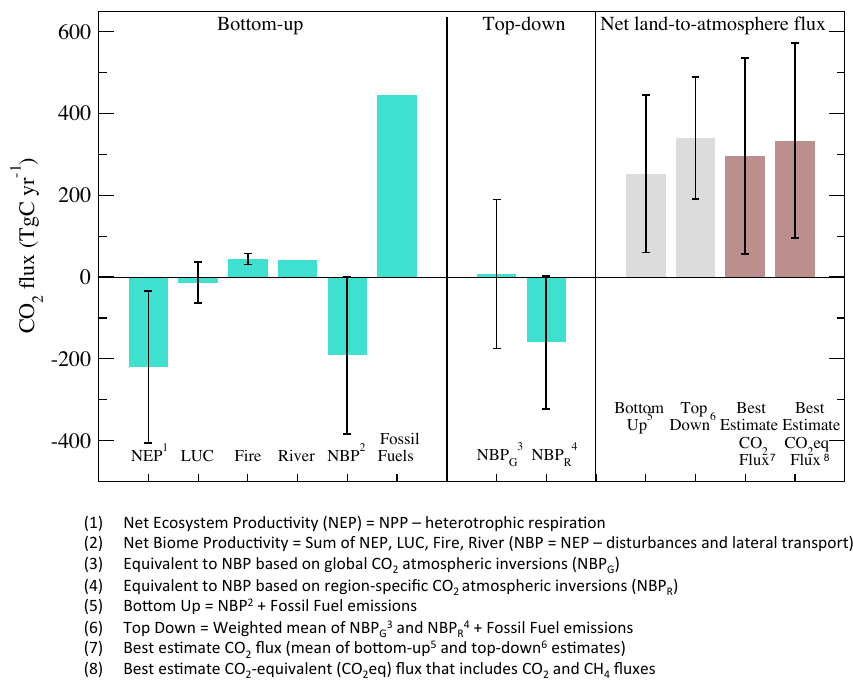
Fig. 5. Decadal mean CO 2 fluxes from various estimates and flux components. The period of estimations differ for source types (ref. Tables 5 and 6 for details). Table 5. Decadal average CO 2 fluxes from the South Asian region using bottom-up estimations, top-down estimations and terrestrial ecosys- tem models. The range of estimate is given as maximum and minimum, and 1- σ standard deviations as the estimated uncertainty or from interannual variability